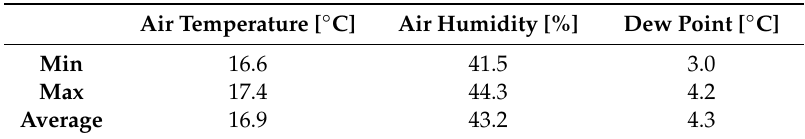
Table 6. Indoor microclimate after the application of insulation. Measurement taken from 17 February 2018 to 18 February